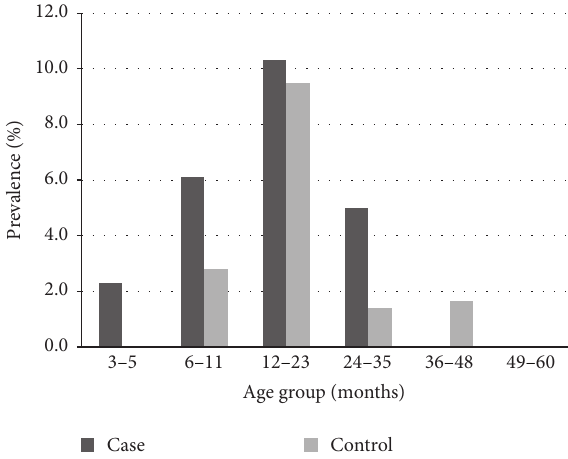
Figure 1: Prevalence of norovirus GI and GII infection in children with acute diarrhea (cases) and nondiarrheal controls by age. Samples were collected from children aged 3 months to 5 years who attended the National Pediatric Hospital in Phnom Penh, Cam- bodia, between November 2004 and October 2006. A significant difference ( 𝑝 < 0.05 , t -test) in the mean of age of infection was observed between cases and controls averaging at 12.4 months and 20.3 months,